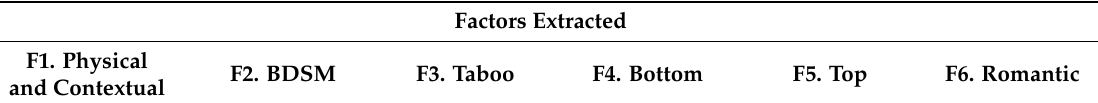
Table A4. Principal Component Analysis Matrix ( n = 887)–SDEF3 6-Factor Solution Extracted